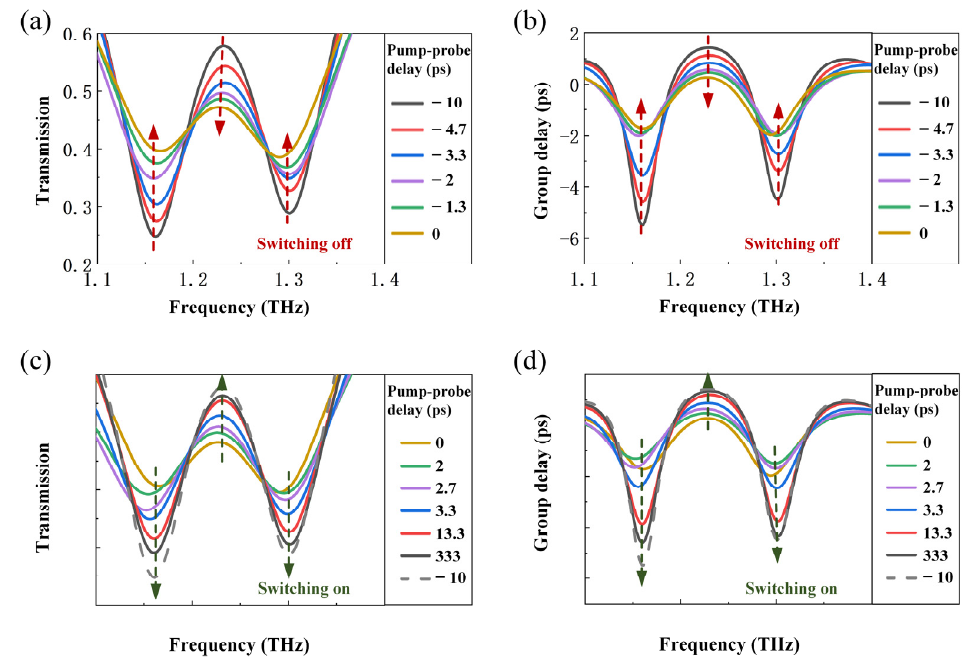
Figure 5. Ultrafast switching of the EIT resonance under pump fluence of 3200 μ J/cm 2 . ( a , b ) The switching-off process of transmission spectra and group delay spectra as a function of pump–probe delay, respectively. ( c , d ) The switching-on process of transmission spectra and group delay spectra at various pump-probe delays, respectively. Table 1. Comparison of the ultrafast all-optical tuning